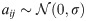
Probability of feasibility for different models in the regime of moderate interaction strength.(a) Analytical prediction for the random model. Insert: the scaled colors express PS as a function of both S and σ. (b-g) Predictions (with 95% confidence intervals) from 1000 simulations for random mutualistic networks, random competitive networks, random predator-prey networks, the cascade model [17], the niche model [18], and the nested-hierarchy model [30], respectively. We choose aij∼N(0,σ) for any non-zero entry of the interaction matrix A in the random model; in the other cases, a strictly positive interaction is randomly drawn from a folded normal distribution such that aij∼|N(0,σ)|, and a strictly negative interaction is sampled such that aij∼-|N(0,σ)|. The parameters are C = 0.25, σ = 0.4, and θ = −1.